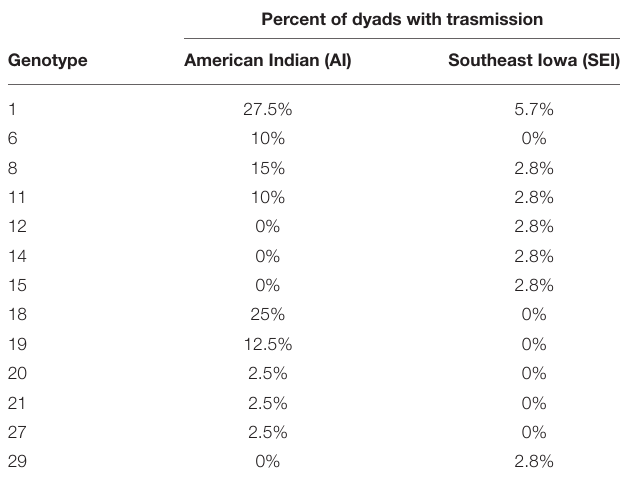
TABLE 1 | Genotypes displaying fidelity of transmission from mother to child in ≥ 1 mother-child